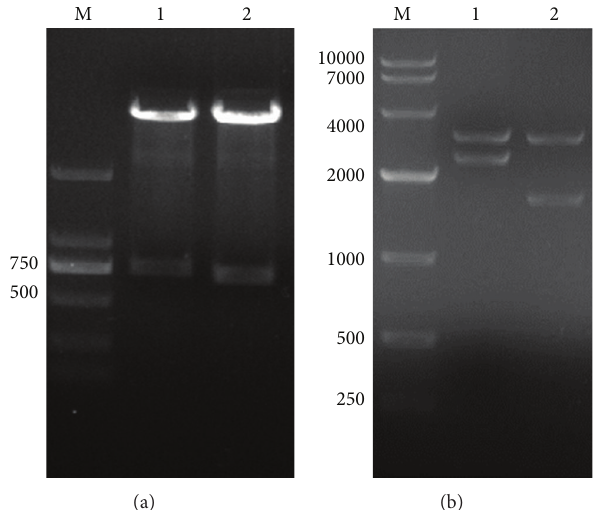
Figure 8: Verification of Fab soluble expression vector by Not I digestion. (a) M: marker DL2000; lanes 1-2: number 1 and number 2 clones were digested by Spe I/Nhe I for deleting gIII fragment. (b) M: marker DL10000; lane 1: recombinant with no gIII deletion digested by Not I ; lane 2: recombinant after gIII deletion digested by Not I .